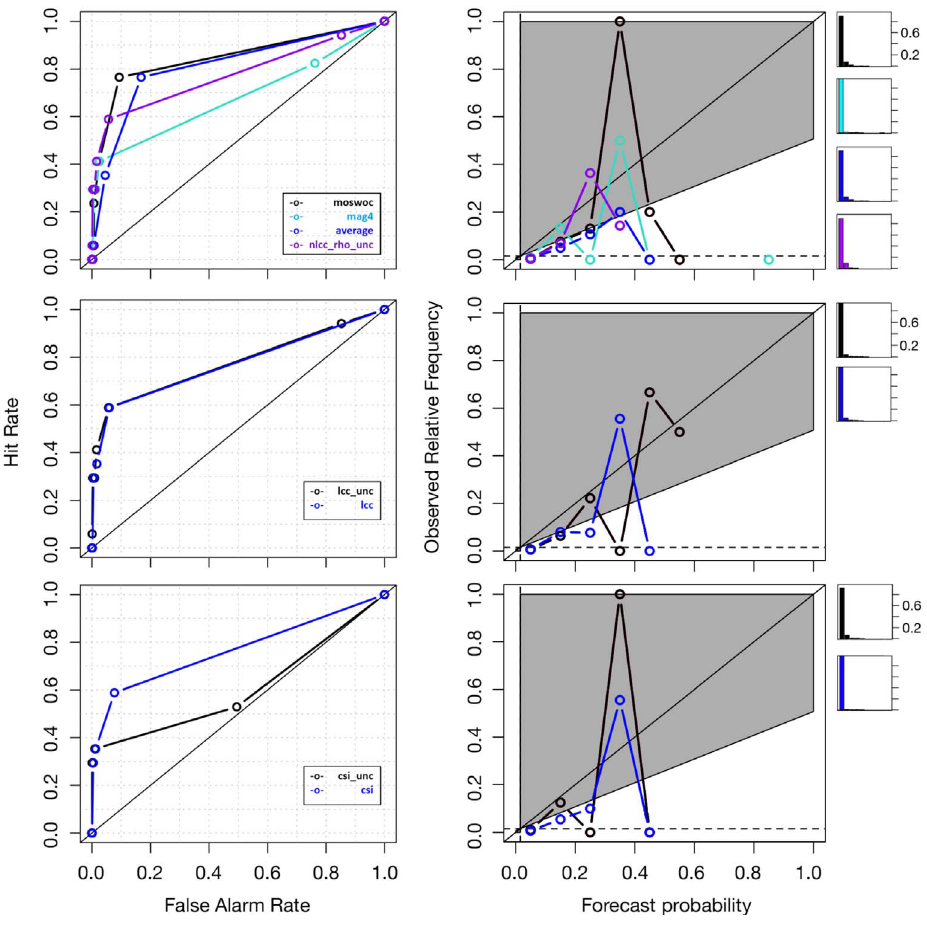
Fig. C.4. Same as Figure 6, but for X-class fl are